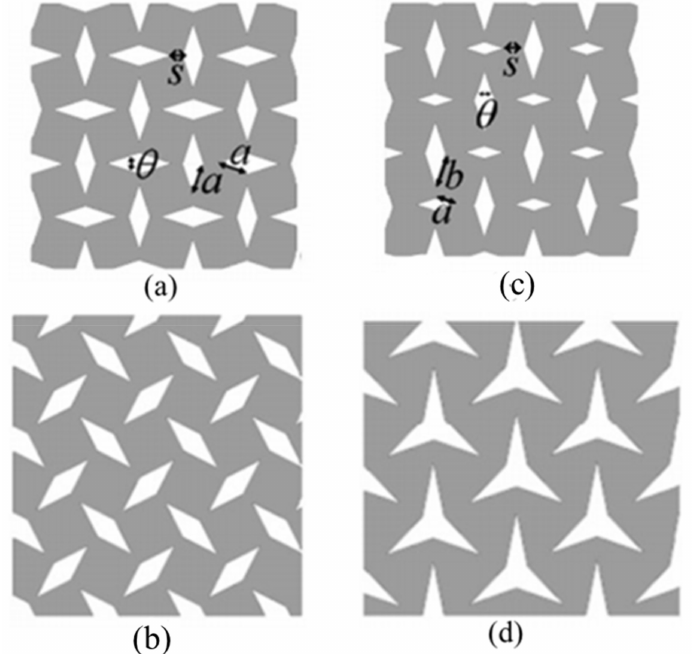
Figure 19. Perforated sheet systems. ( a , b ) Diamond-shape inclusions of the same size but at di ff erent orientations; ( c ) diamond-shaped inclusions of di ff erent sizes, and ( d ) star-shaped inclusions